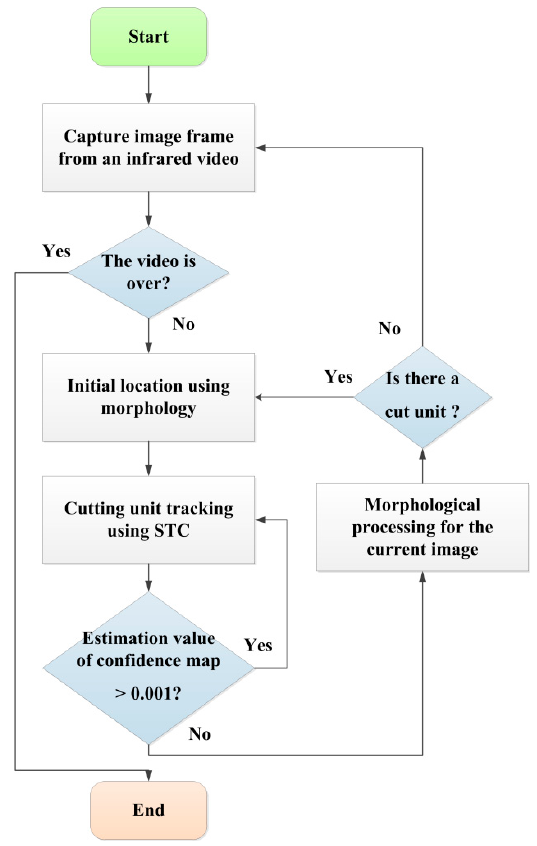
Figure 7. Flowchart of the shearer cutting unit tracking method.